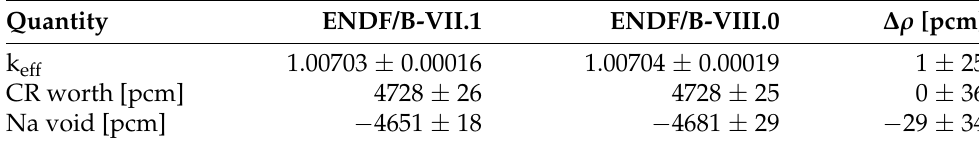
Table 3. Nominal values of quantities of interest determined with